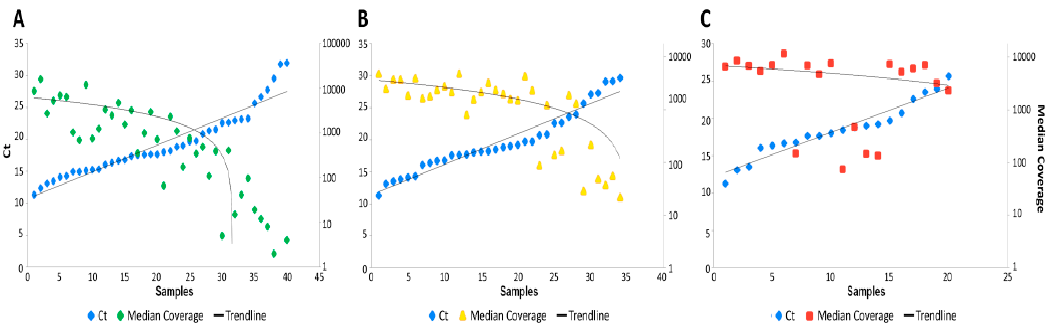
Figure 3. Correlation of Ct (reflecting the viral load) to median coverage of reads which were mapped to target regions. Sequenced samples without controls: NEB + TWIST1,2; ( A ) 40 samples, Illumina; ( B ) 35 and Paragon; ( C ) 20 (19 prepared amplicon libraries, including 4 controls, were excluded from sequencing—did not meet the QC limit). (In a graph NEB + TWIST1,2 are presented together with samples of both independent preparations). Min / max Ct values: NEB + TWIST1,2 (11.29–32.96), Illumina